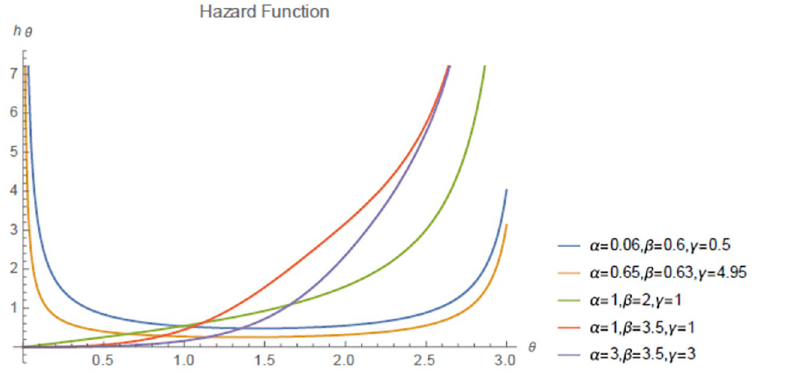
Fig 3. Plot of the hcMB − III hazard rate.